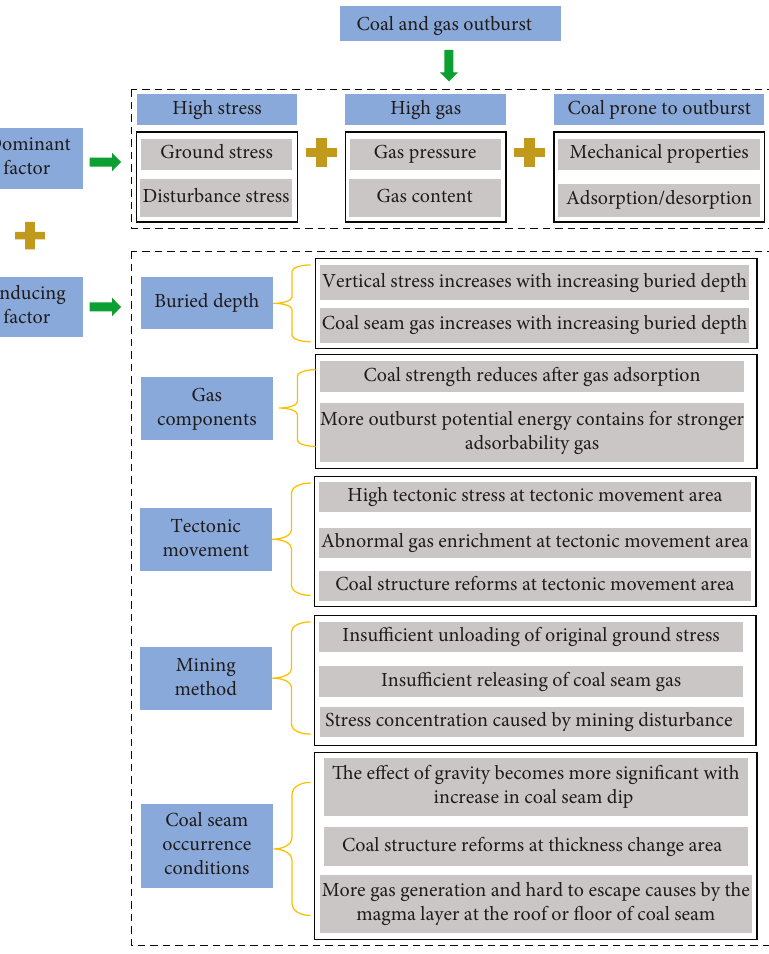
Figure 2: Analysis of internal relations of factors of coal and gas